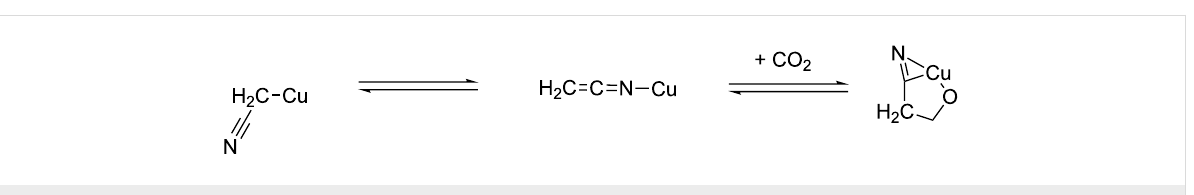
Scheme 6: Formation of copper(I) cyanoacetate for the activation of CO 2